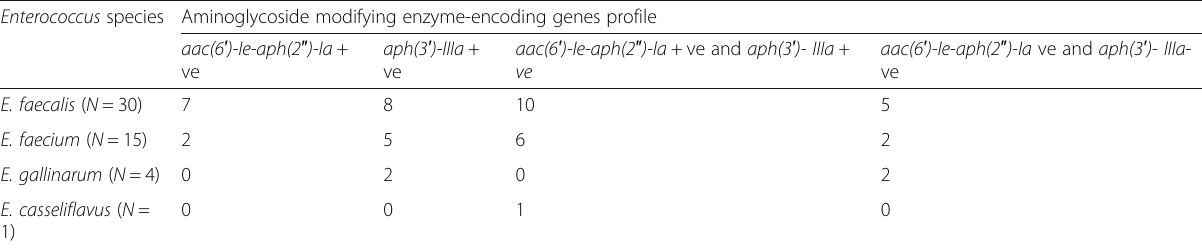
Table 4 Aminoglycoside modifying enzyme-encoding genes profile among the 50 high-level aminoglycoside resistance Enterococcus species